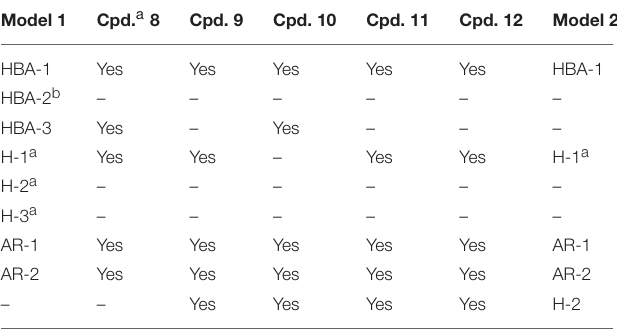
TABLE 2 | Detailed analysis of pharmacophore features mapped by all novel inhibitors 8-12 of CYP11B1 and CYP11B2. Model 1